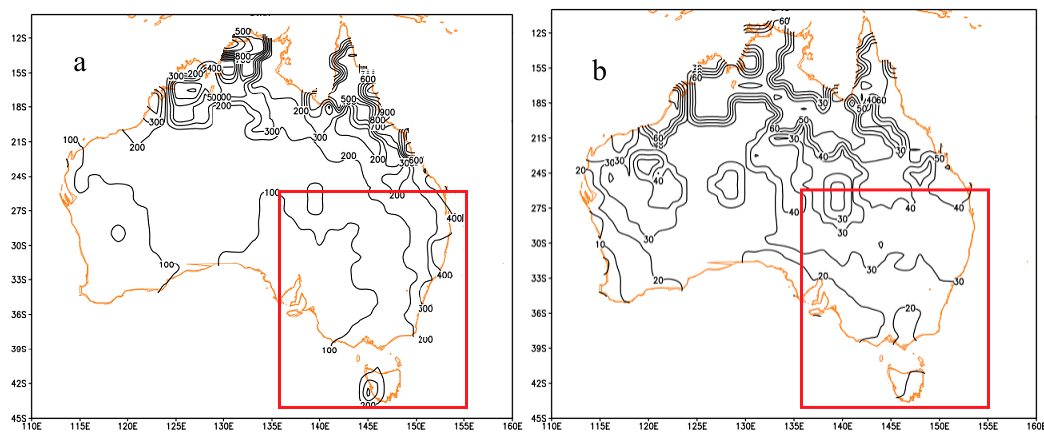
Figure 2. Averaged ( a ) austral summer rainfall (units: mm; contour interval: 100 mm) and ( b ) summer rainfall percentage (units: %; contour interval: 10%) during December–January–February (DJF) 1980–2017. The red rectangle denotes the location of southeastern Australia (25–44° S, 136–155° E).